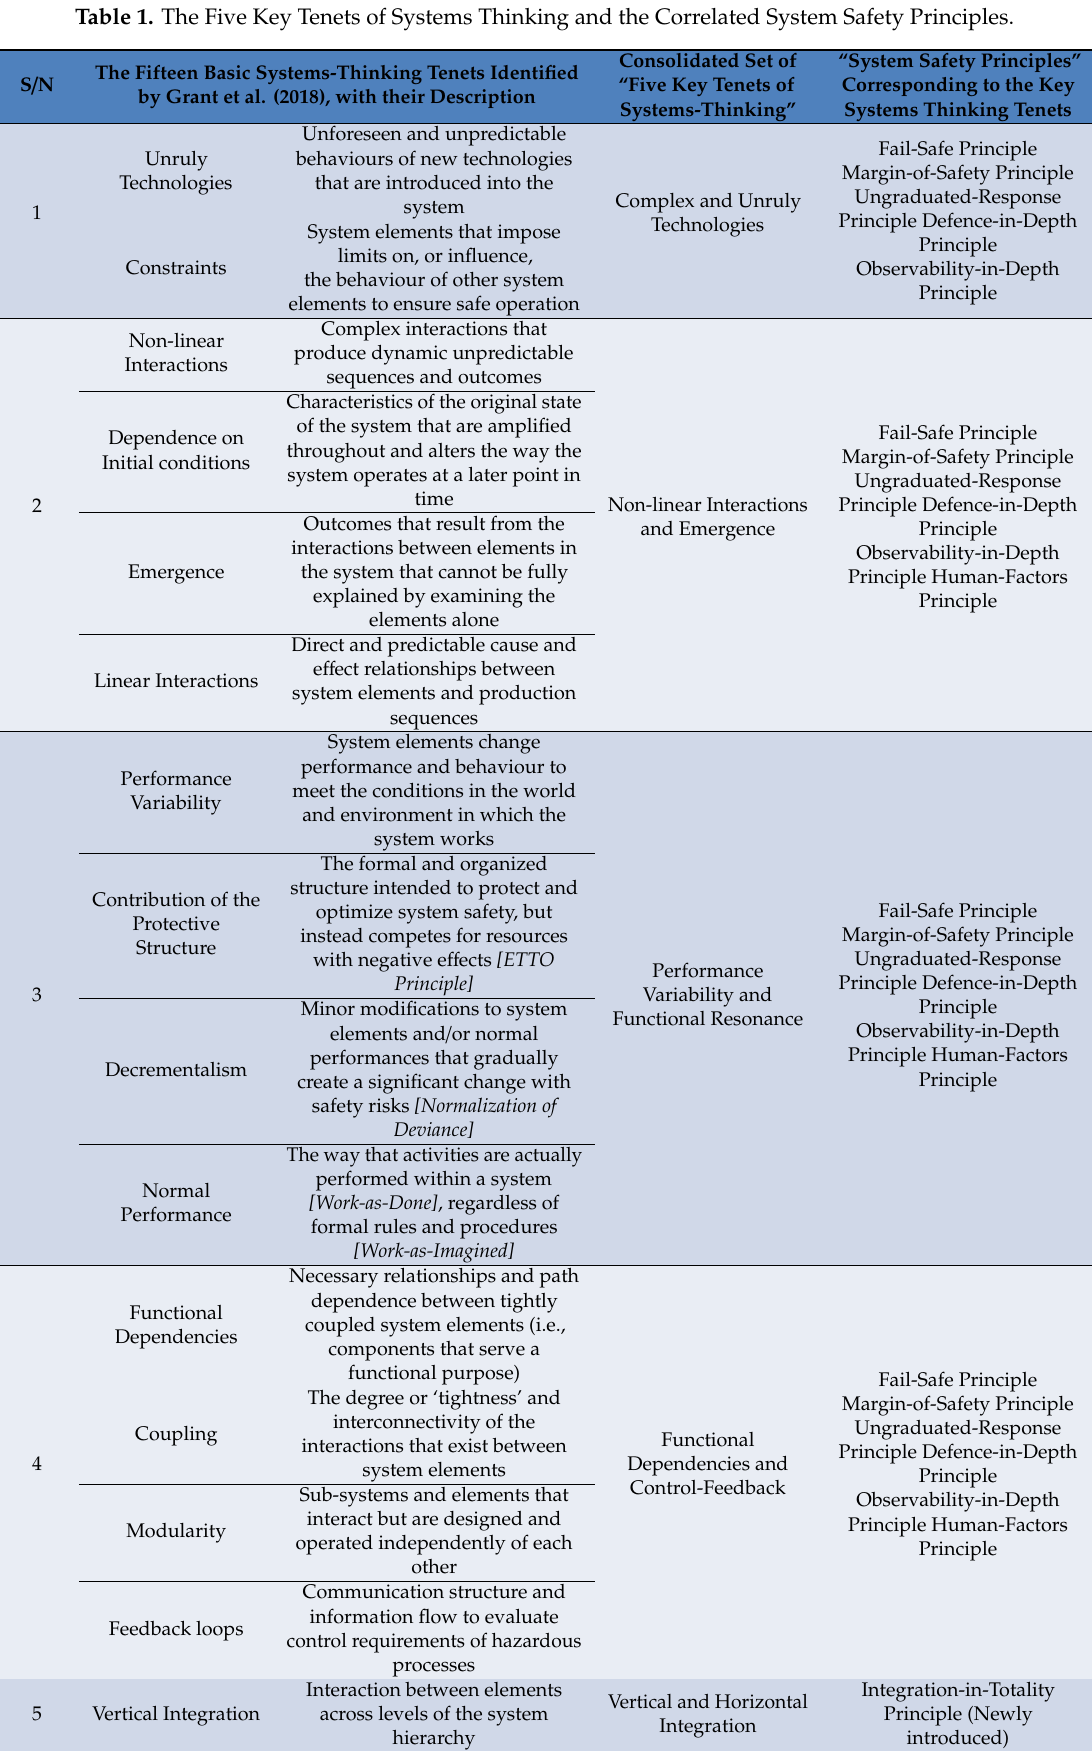
Table 1. The Five Key Tenets of Systems Thinking and the Correlated System Safety Principles. The Fifteen Basic Systems-Thinking Tenets Identified S / N by Grant et al. (2018), with their